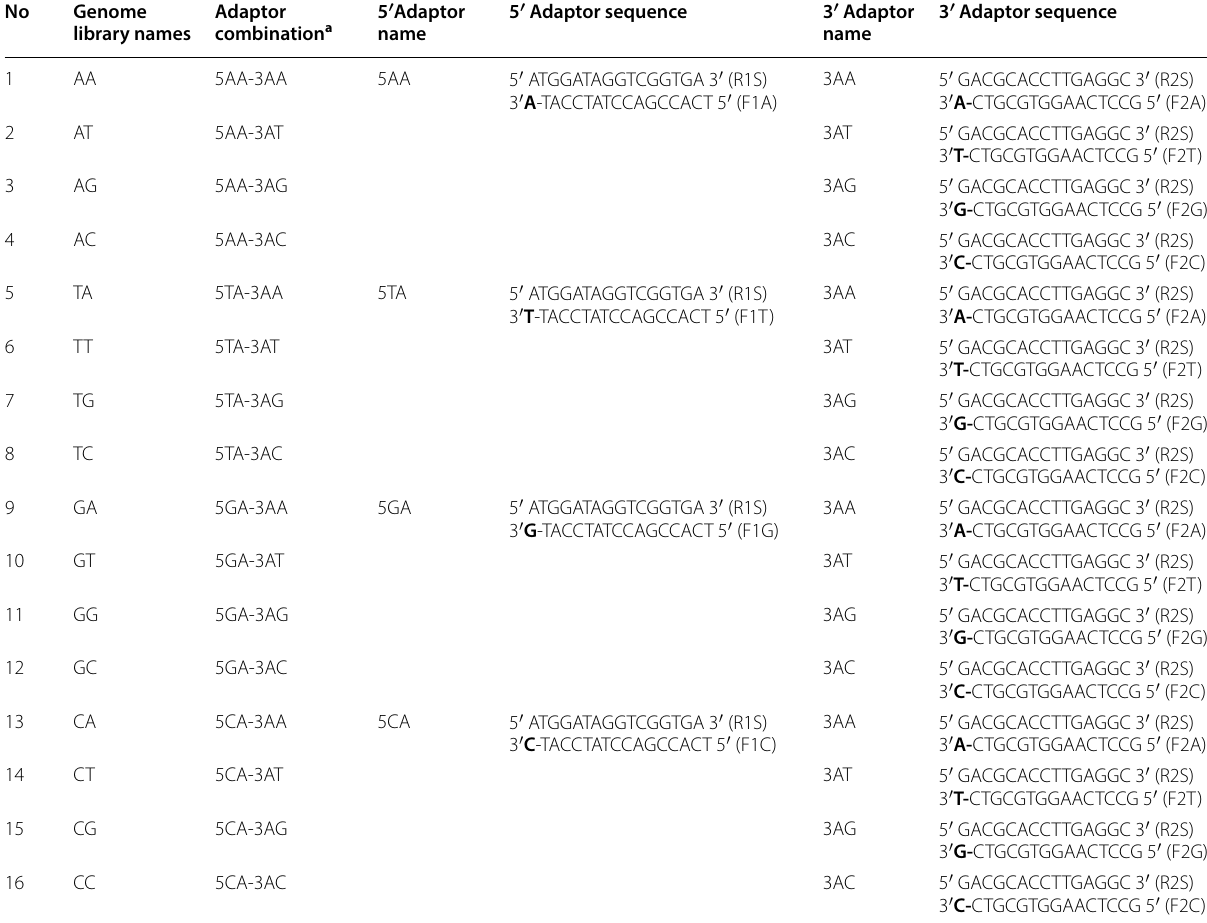
Table 1 Sixteen genome libraries generated from combination of eight adaptors sequences randomly digested by Mnl I restriction